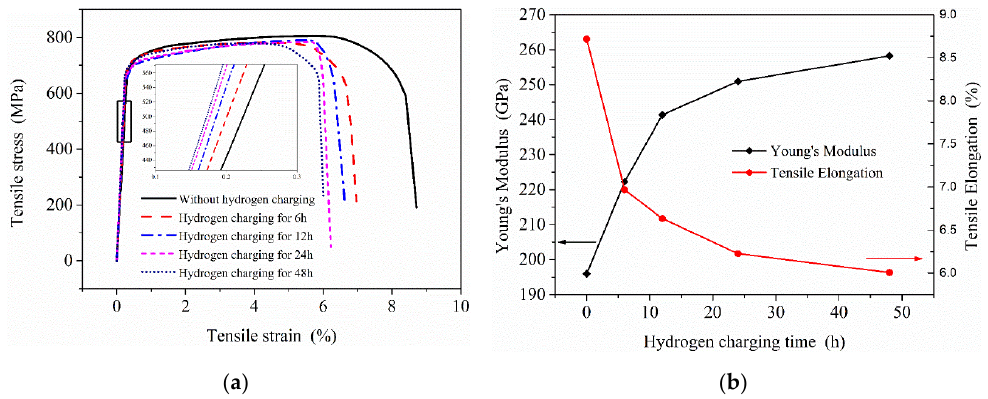
Figure 12. Effects of hydrogen charging on the mechanical properties of 2.25Cr1Mo0.25V steel: ( a ) stress–strain curves of samples under different hydrogen charging time; ( b ) the change of Young’s modulus and tensile elongation.